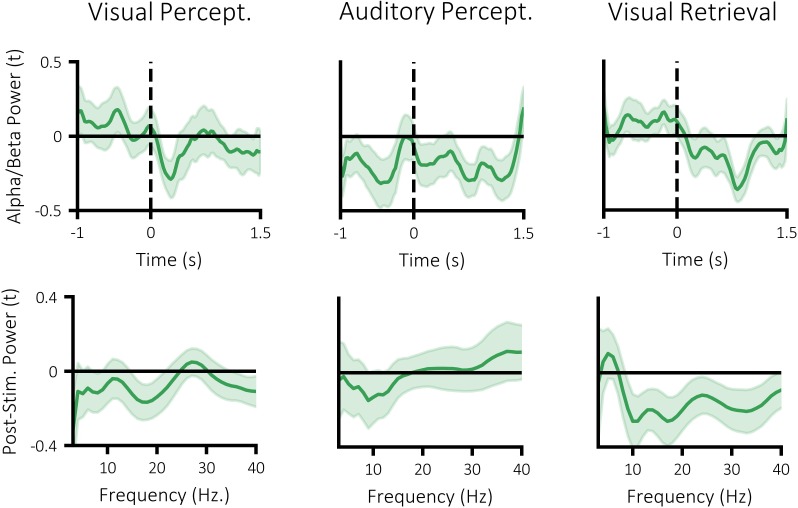
Specificity of power-similarity correlation across time (top) and frequency (bottom).Dark line indicates mean across participants and shaded area indicates standard error of the mean. A negative value indicates a negative relationship between power and stimulus-specific information. All analyses were conducted on an a priori window ranging from 8 to 30 Hz, 500 to 1500 ms post-stimulus.